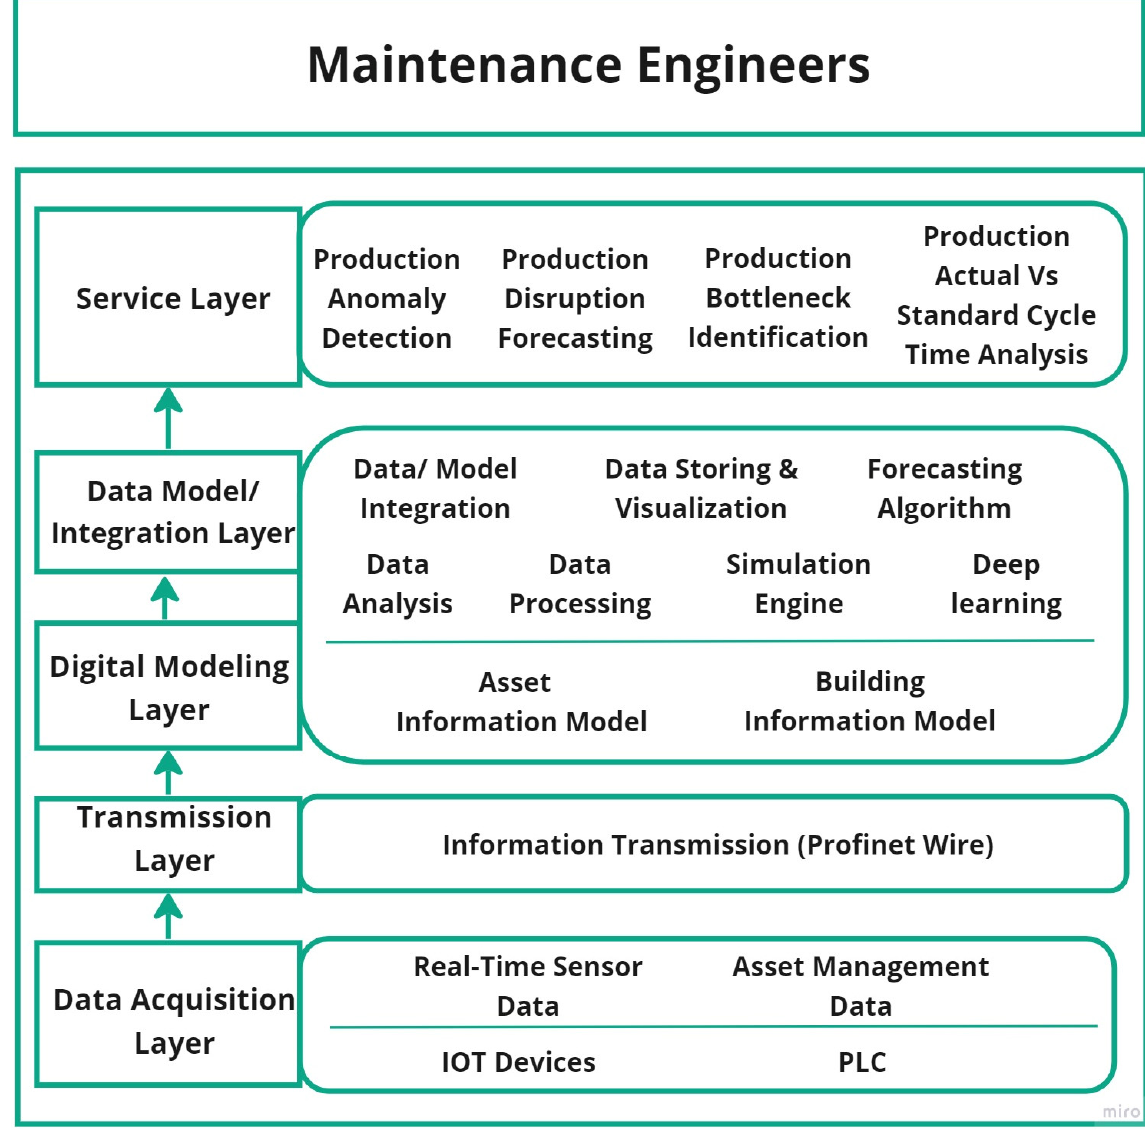
Figure 6. Digital Twin System Architecture for Ready-Mix Concrete Plant Layout.